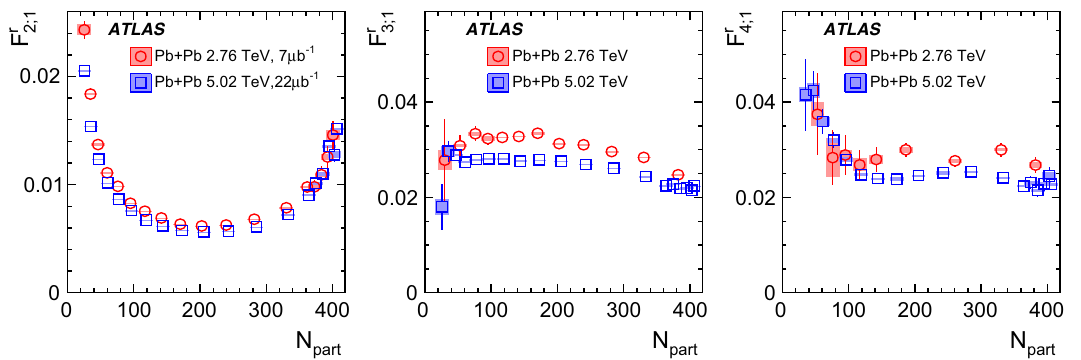
Fig. 11 Centralitydependenceof F r (leftpanel), F r (middlepanel) atic uncertainties, respectively. The widths of the centrality intervals are 2 ; 1 3 ; 1 and F r (right panel) for Pb+Pb at 2.76 TeV (circles) and 5.02 TeV not fixed but are optimised to reduce the uncertainty 4 ; 1 (squares). The error bars and shaded boxes are statistical and system-